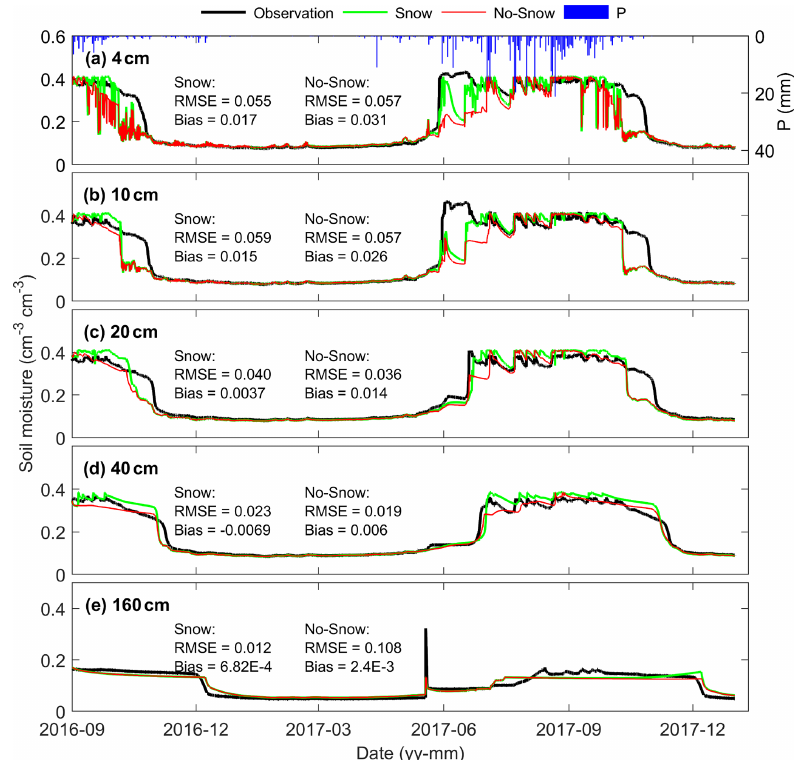
Figure B4. Observed and estimated soil moisture at various soil layers using the model with and without the snow